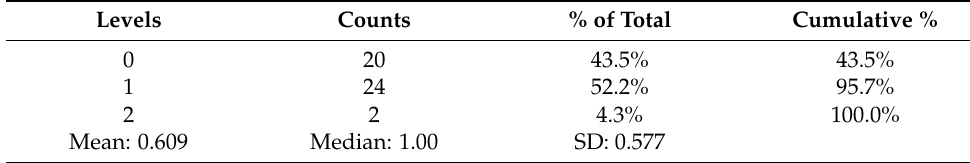
Table 3. “Cohort for Validation”